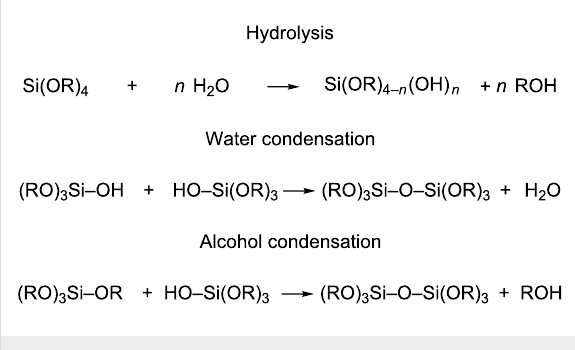
Scheme 1: Simplified sol–gel mechanism reaction for a tetraalkoxy- silane